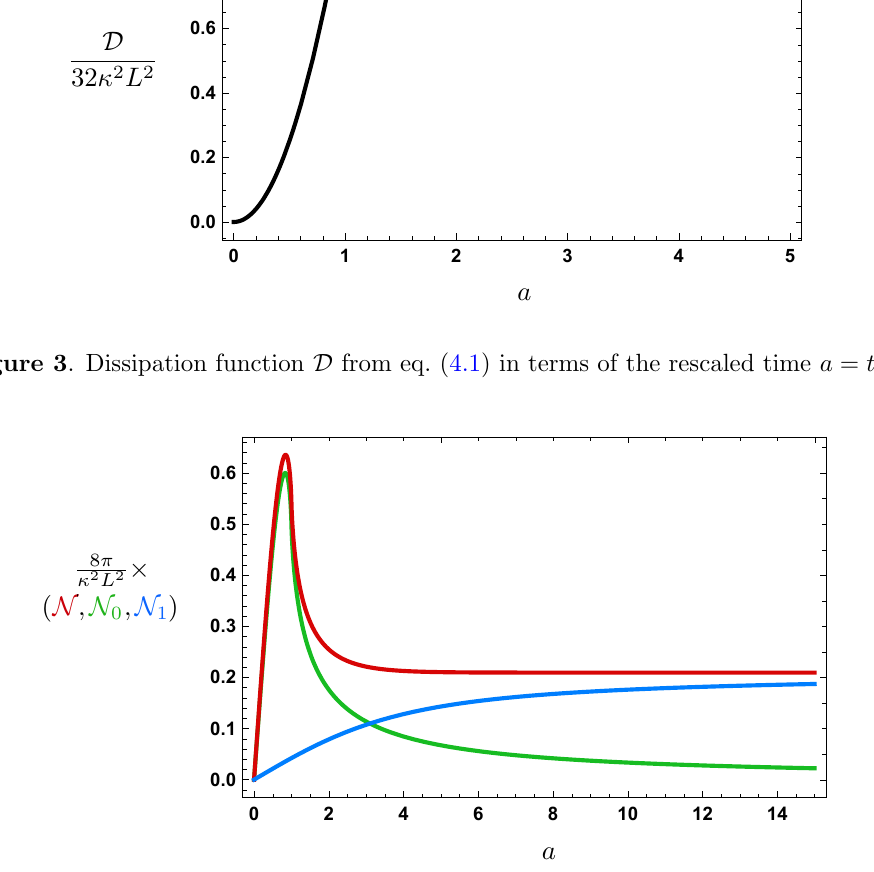
Figure 4 . The noise function from eq. (4.4) (red), written as the sum of its zero-point part N N 0 (green) and Bose-Einstein occupation number contribution (blue) from eq. (4.2), as a function N 1 of the rescaled time a = t=L . In this example, the functions are plotted for rescaled inverse temperature b =